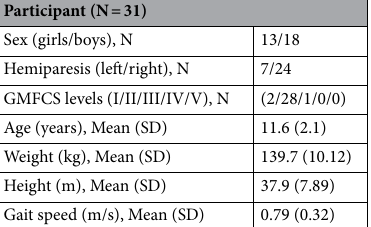
Table 1. Characteristics of the study participants. N—Number of participants, SD—standard deviation, GMFCS—Gross Motor Function Classification